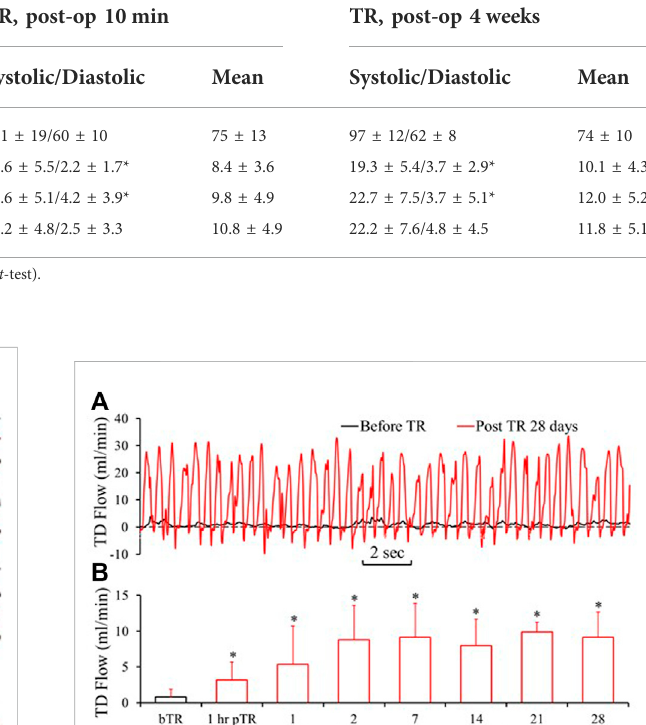
TABLE 1 Pressures in the swine model of TR (unit: mmHg).